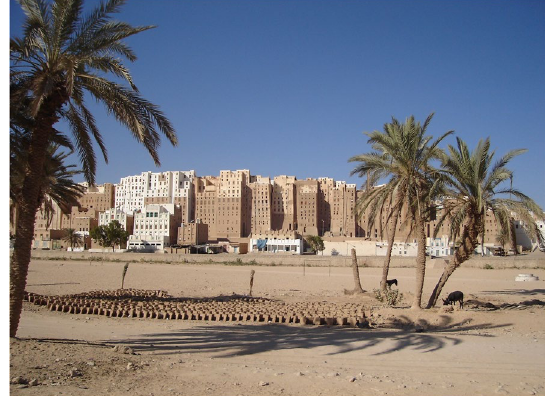
Fig. 1 Shibam, with mud-brick production in the dry riverbed (Source: the